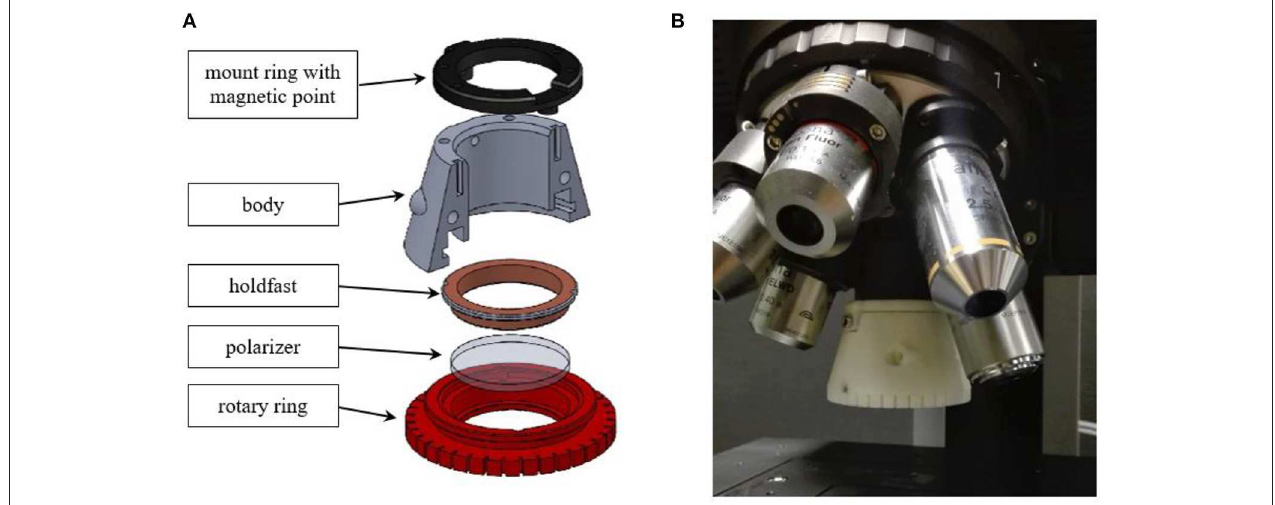
FIGURE 5 | External polarizer placed in front of the lens of the ALICONA profilometer for the use of light coming of the lens: (A) the view of a cross-section of the external polarizer fixing and (B) the actual assembly of the polarizer on the lens of the ALICONA profilometer.